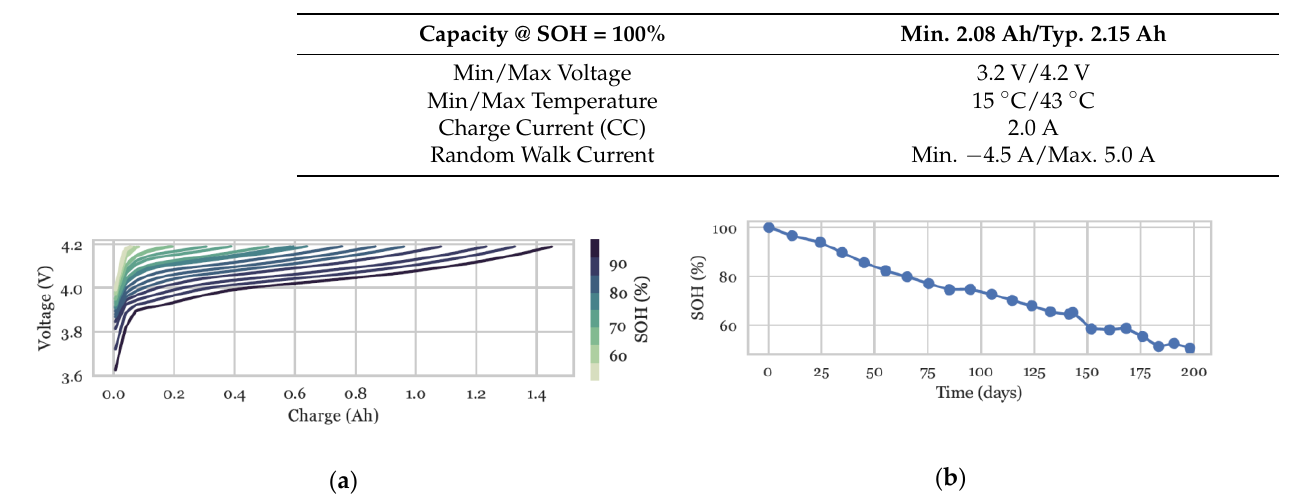
Table 1. Randomized Battery Usage Dataset parameters.